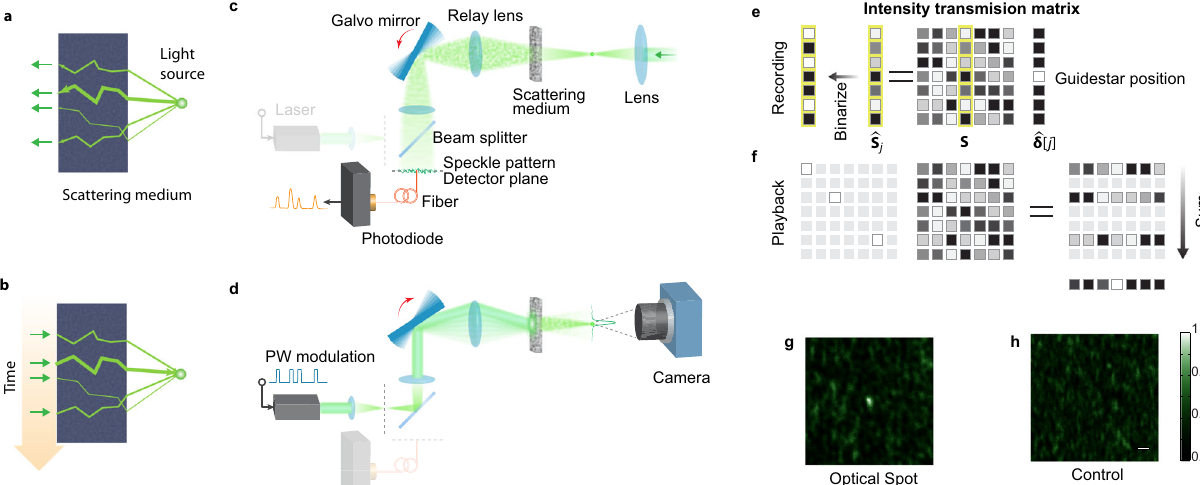
Fig. 4 Optical intensity transposition. a , b The principle of optical intensity transposition. a Light emitted from a coherent light source at the target plane traverses the optical channels to the input plane. By measuring the light intensity of the transmitted light as a function of space, we can obtain a spatial map of the optical channels. b By sending light back through the bright channels and linearly combining the transmitted light, we can obtain a focus pattern at the source location. c , d Experimental setup. Similar to optical phase conjugation, the retrore fl ecting process can be separated into two steps. c Recording. A point source transmitted light through the scattering medium and a photodiode measures a one-dimensional speckle pattern during one galvo mirror sweep. d Playback. The measured signal is time-reversed and then modulates the laser on the input side as the galvo mirror scans backward. An optical spot is created at the position of the initial point source. e , f Matrix representation of optical intensity transposition. During recording e , a guidestar selects a column of the intensity transmission matrix as a time-varying intensity output, which is then binarized. During playback ( f ), the binarized signal is used to select the corresponding rows of the intensity matrix, whose sum leads to a bright optical spot at the guidestar position. g , h Experimental results. An optical spot pattern was imaged on a camera with optical intensity transposition ( g ), while no bright spot was observed in the control experiment where we disabled the synchronization between the playback sequence and the galvo mirror ( h ). Scale bar: 20 μ